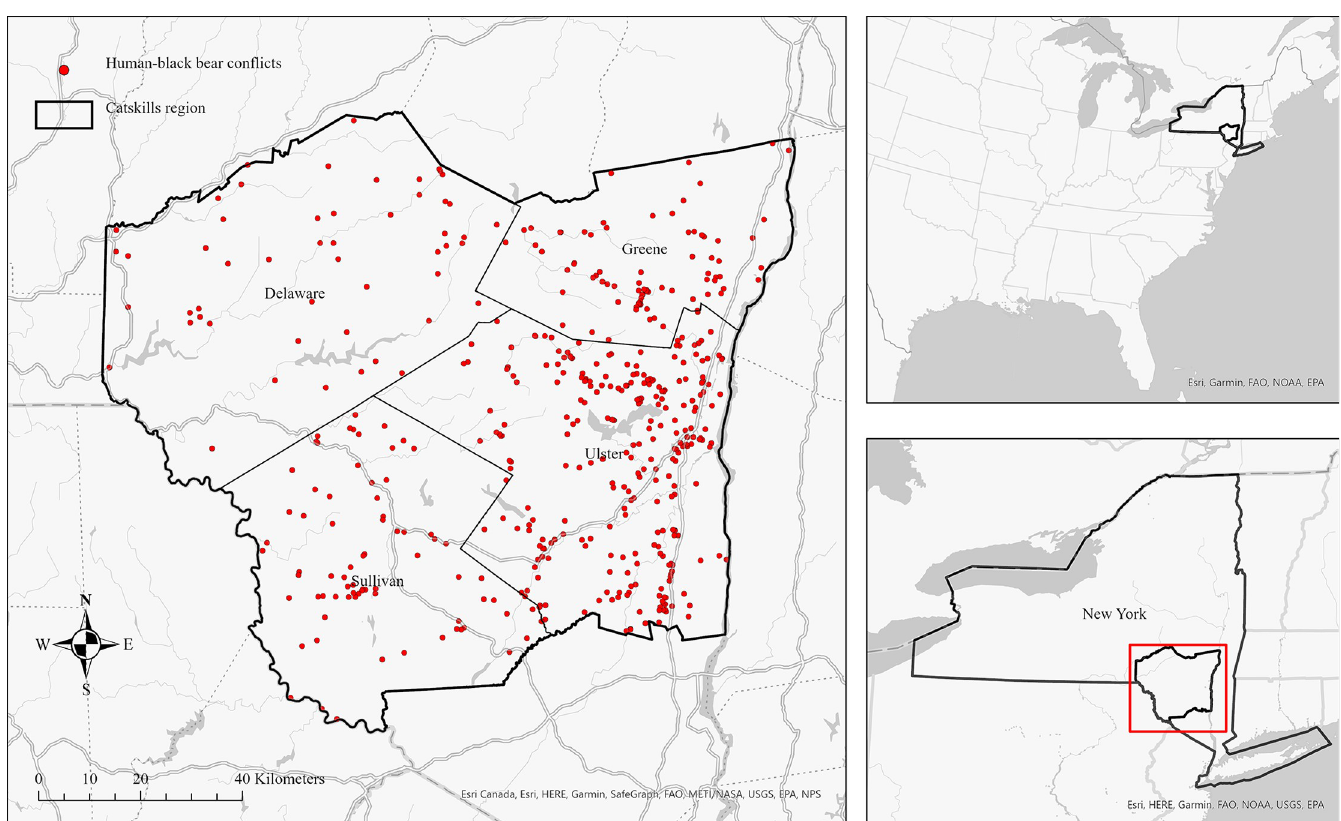
Fig 1. Human-black bear interactions (n = 842) recorded by the NYDEC in 2018 and 2019. Catskill counties are Greene, Delaware, Sullivan, and Ulster.